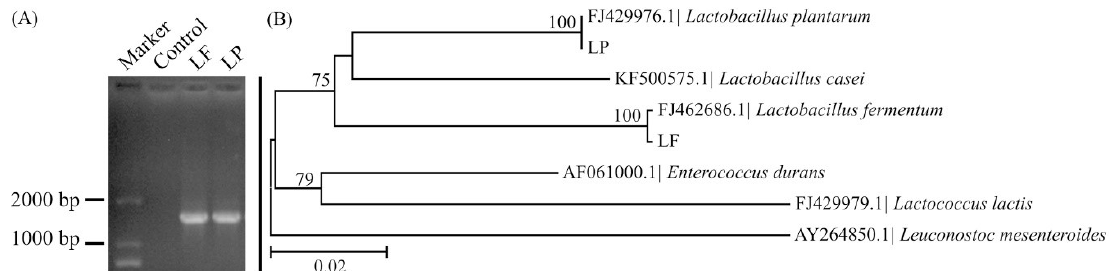
Figure 2. 16S rDNA sequence analysis. ( A ) Detection of PCR product using agarose gel electrophoresis; ( B ) Species analysis using a phylogenetic tree of 16S rDNA sequence.